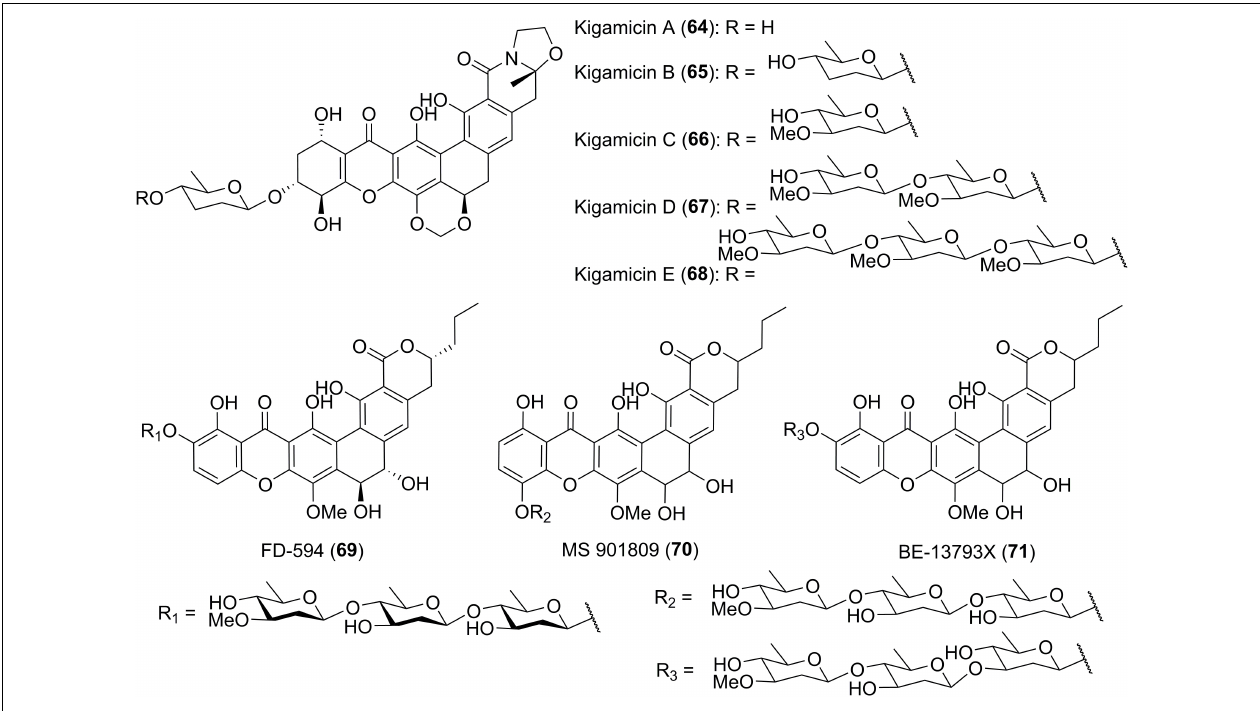
FIGURE 6 | Chemical structures of compounds 64–71 .